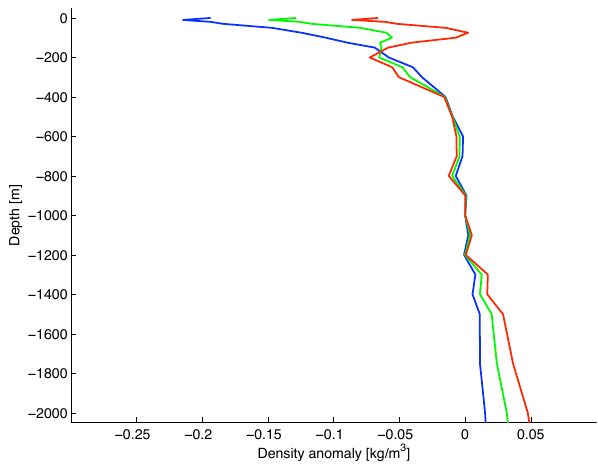
Fig. 5. Potential density profiles with reference pressure of 0db (blue line), 1000db (green line), and 2000db (red line) in the Wed- dell Sea (70 ◦ S–60 ◦ S, 40 ◦ W–0 ◦ W). The profiles are computed using August data from Levitus and Boyer (1994) and Levitus et al. (1994) and the density anomaly is relative to density at